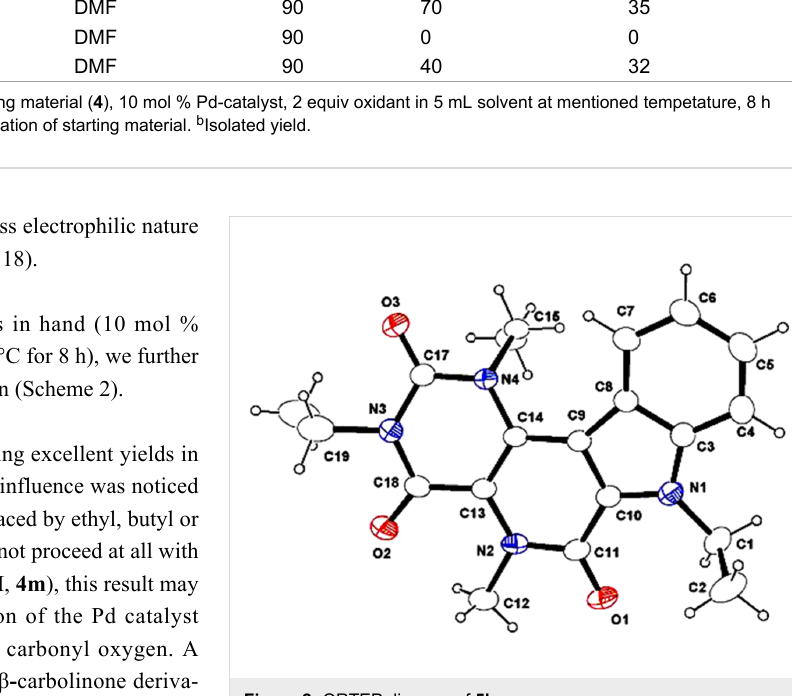
Figure 2: ORTEP diagram of 5h